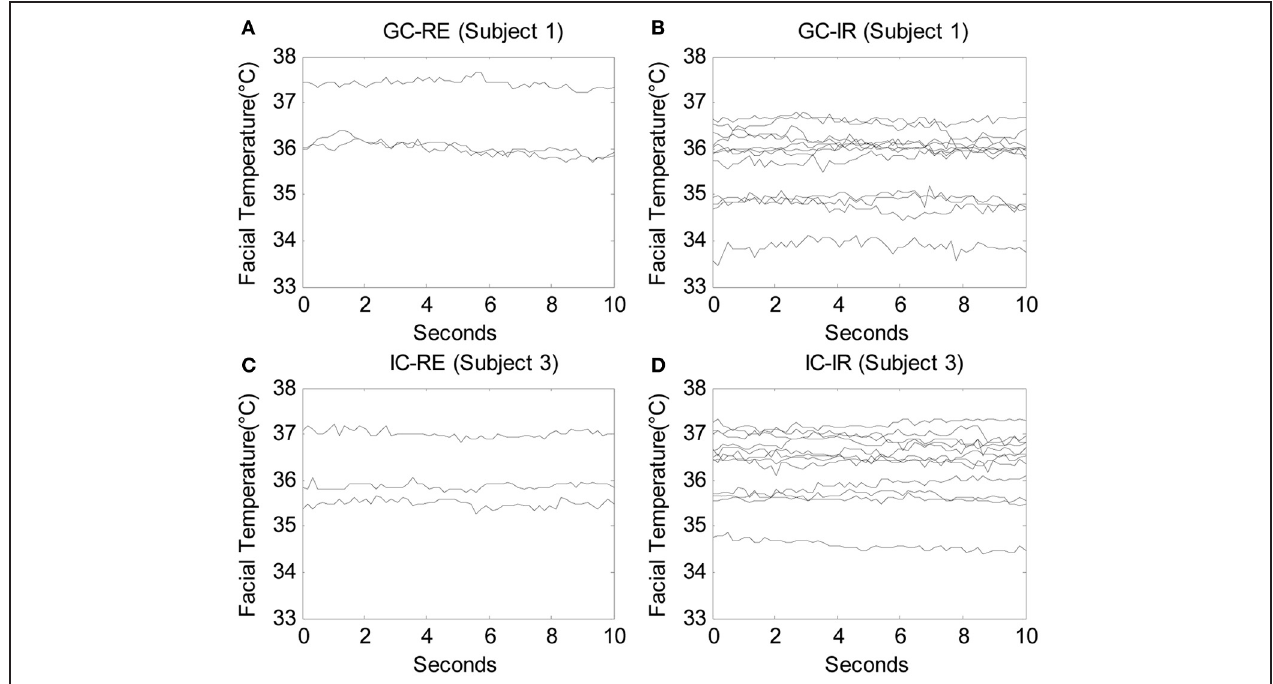
FIGURE 2 | The raw facial temperature data of one guilty subject (subject 1) answering (A) 3 relevant questions and (B) 12 irrelevant questions, and those of one innocent subject (subject 3)